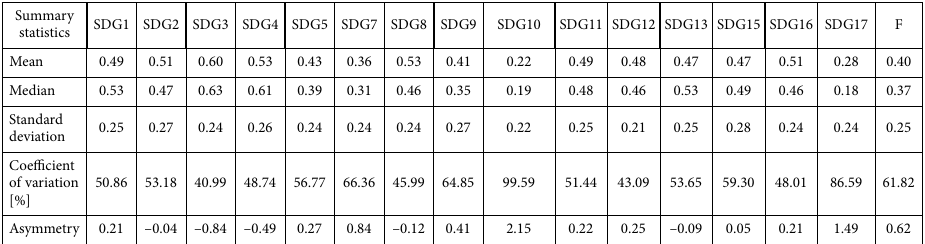
Table 4. The selected summary statistics calculated for taxonomic measures of